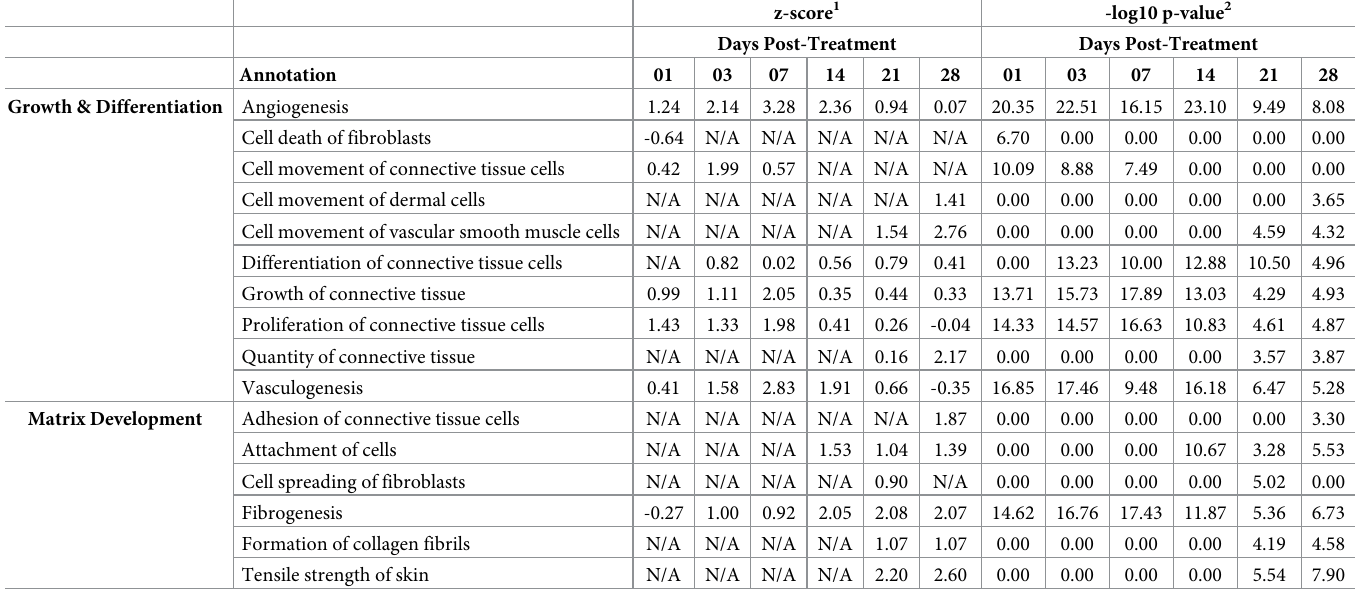
Table 4. Dermal-related biological pathways associated with laser resurfacing